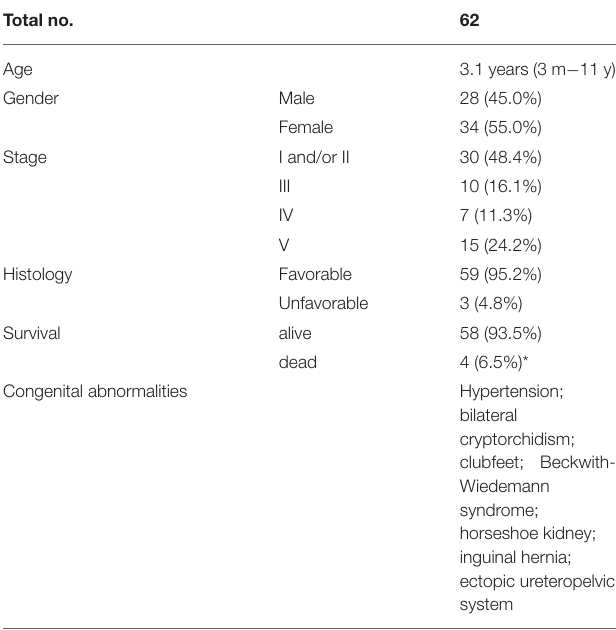
TABLE 5 | Summary of teratoid Wilms tumor cases in the published literature. Total